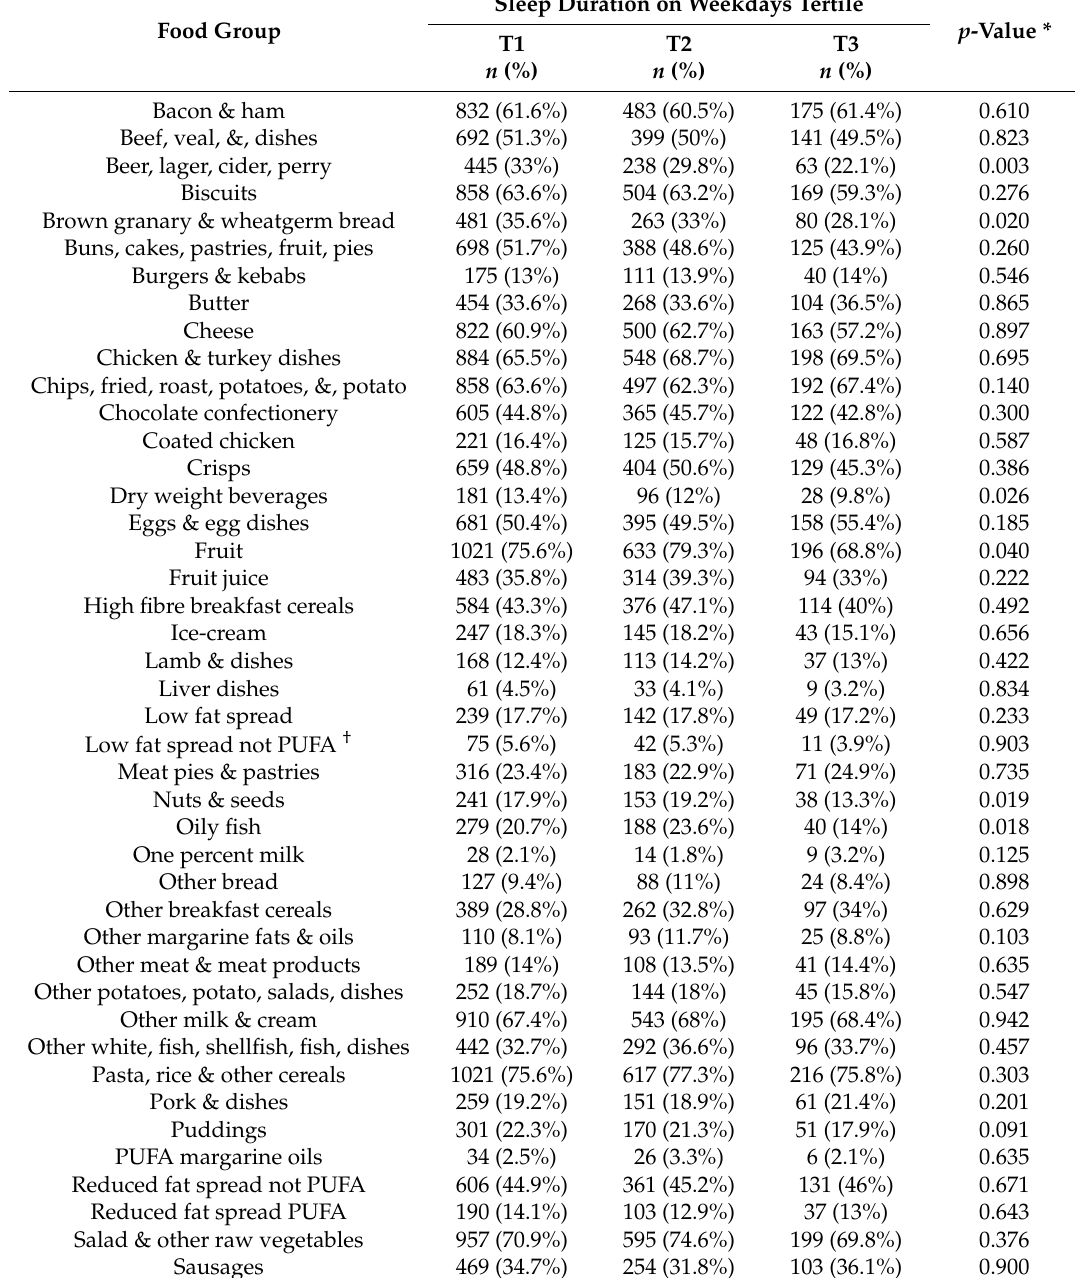
Table 2. Proportion of consumers within each food group within each sleep duration